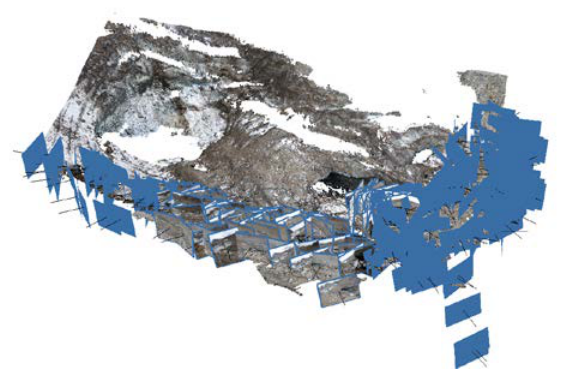
Figure 2. Example of a block of images in Cat. 2, capturing the terminus of the Forni Glacier (Italian Alps).